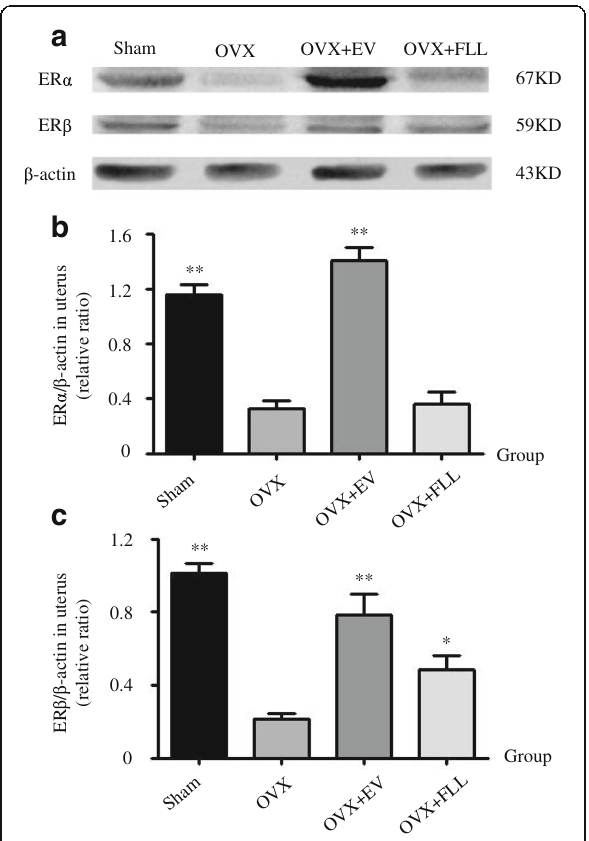
western blot ( b and c ) showing the effects of FLL on the expressions of ER α and ER β in the uteri of the rats. β -actin was taken as the internal control. Data are presented as mean ± SD. * P < 0.05 or ** P < 0.01 compared with the OVX control